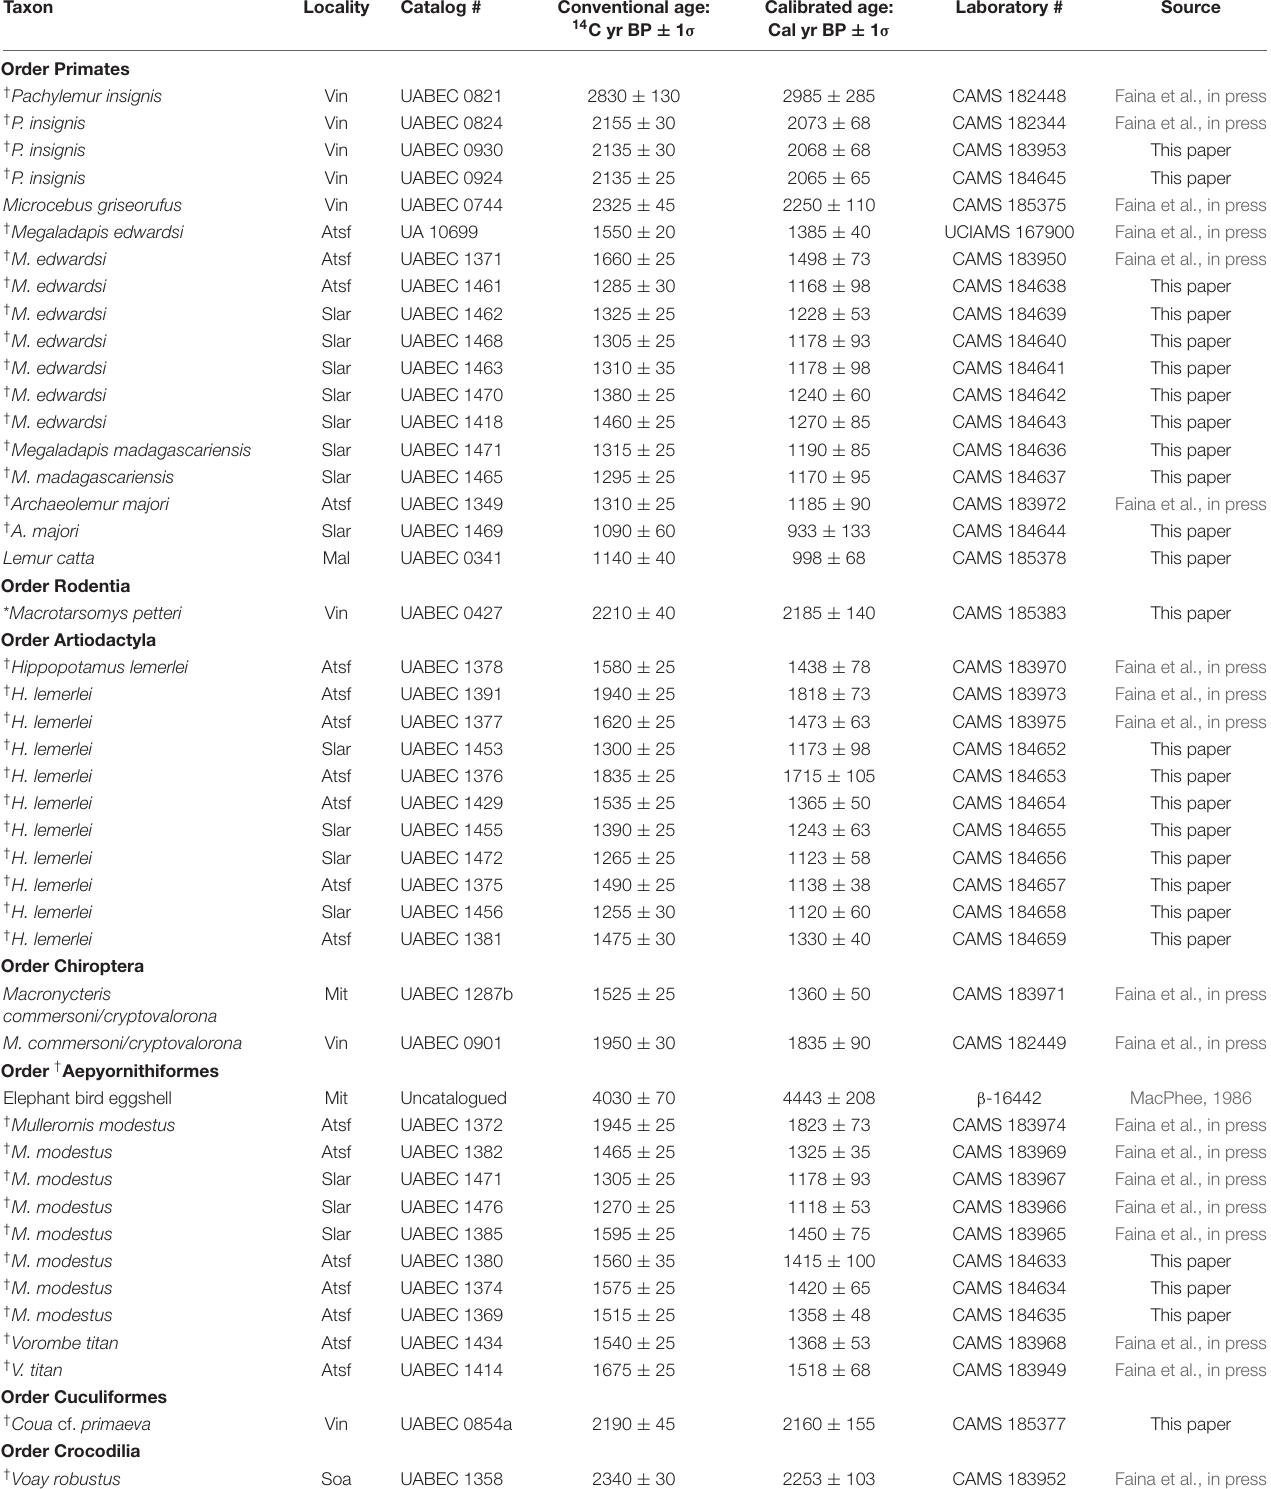
TABLE 3 | TNP/Antsirafaly specimens with conventional and calibrated 14 C dates prior to 900 yr